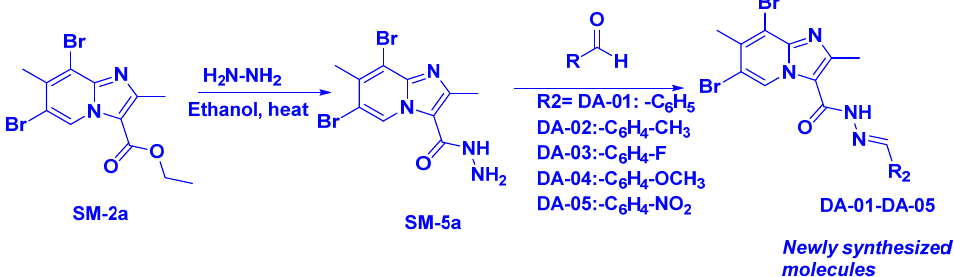
Scheme 1. Reaction scheme for preparation of compounds (SM-IMP-01) to (SM-IMP-13) and (DA-